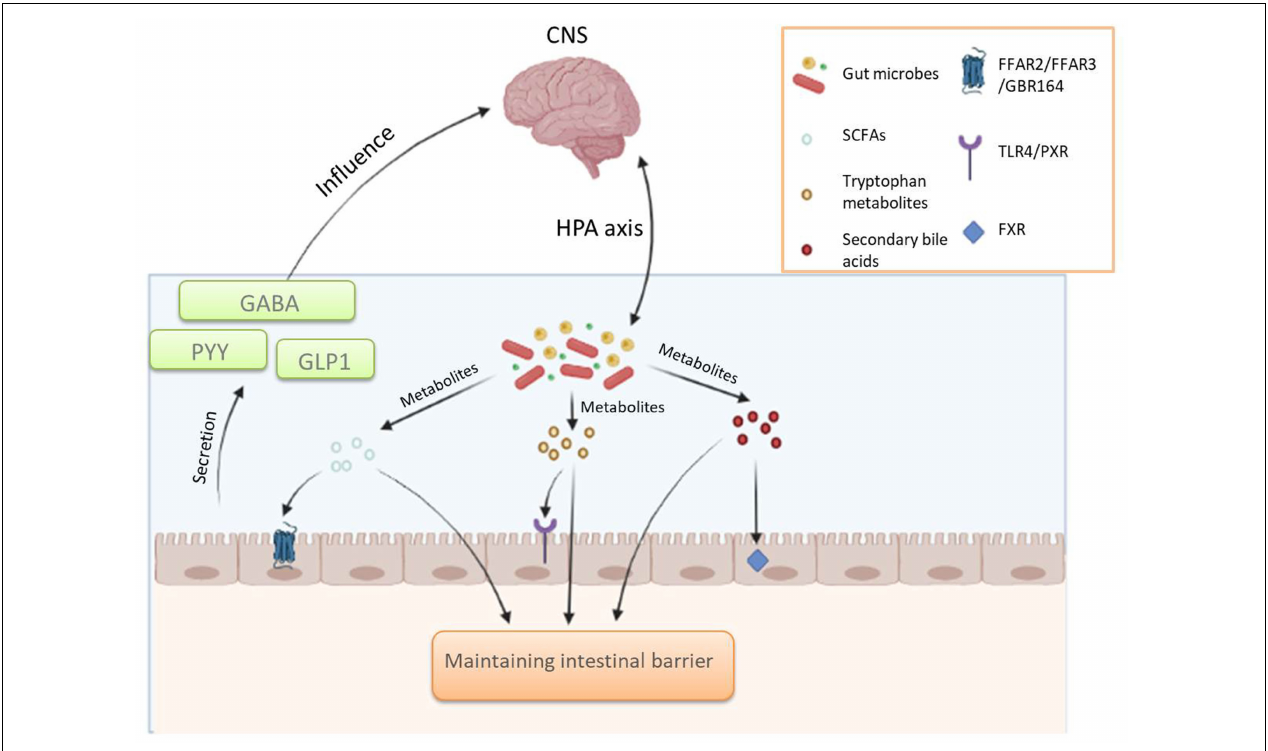
FIGURE 2 | The role of gut microbial pairs in the brain-gut